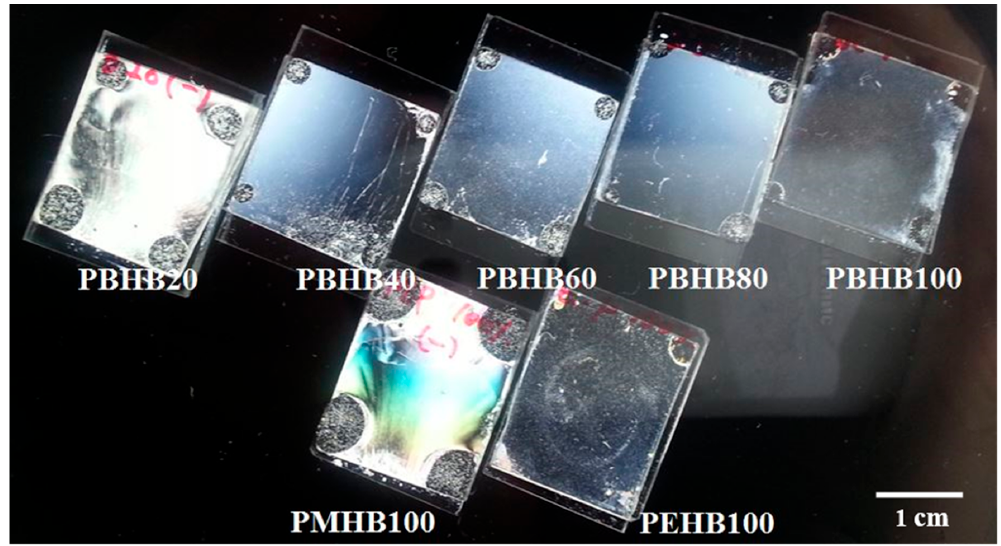
Figure 4. Photograph images of the LC cells fabricated with PBHB# and PMHB100 and PEHB100 films.